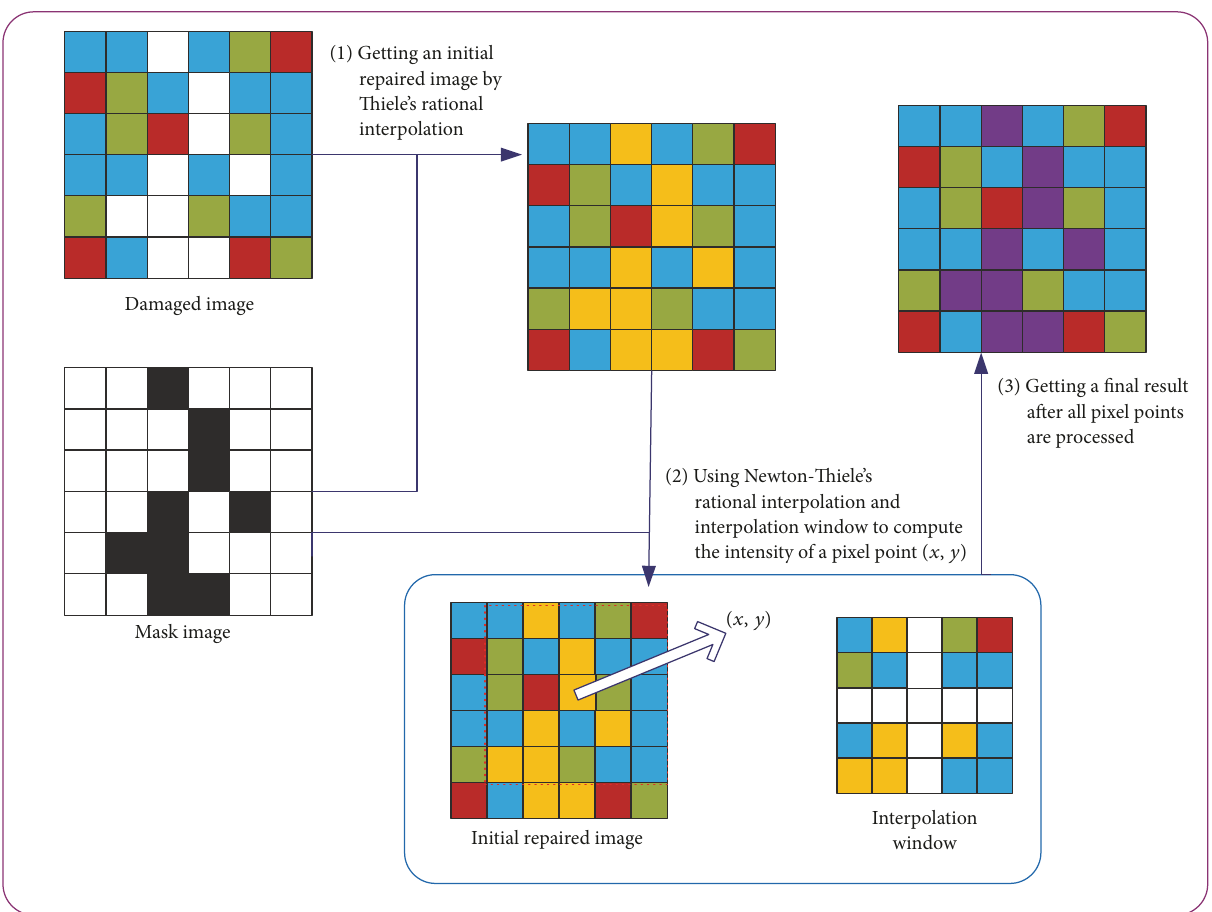
Figure 1: Flowchart of the proposed method. For a damaged image, we use Thiele’s rational interpolation function and the mask image to get an initial repaired image. And then, by using Newton-Thiele’s rational interpolation function, interpolation window, and the mask image, the initial repaired image is refined to get a final